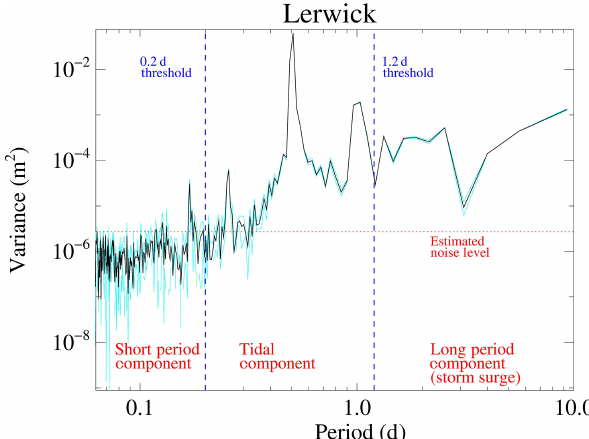
Figure 2. Spectrum of the water level time series from Lerwick, UK for 1–14 November 2007. The original 15min time series was subsampled to give three data sets of 45min resolution from which the spectral mean and standard deviation uncertainty could be calcu- lated, as shown. The noise level was estimated based on the standard deviation of the first difference of the original time